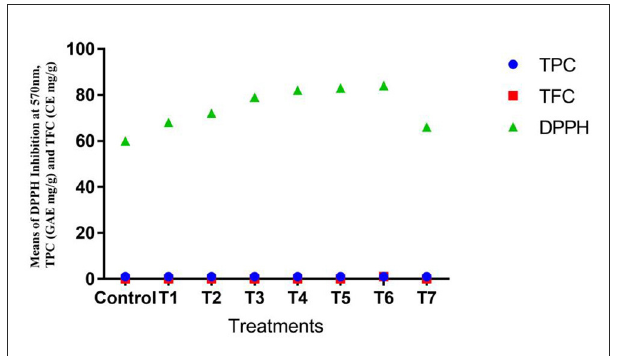
FIGURE3 Sensory evaluation estimated marginal means for functional yogurt